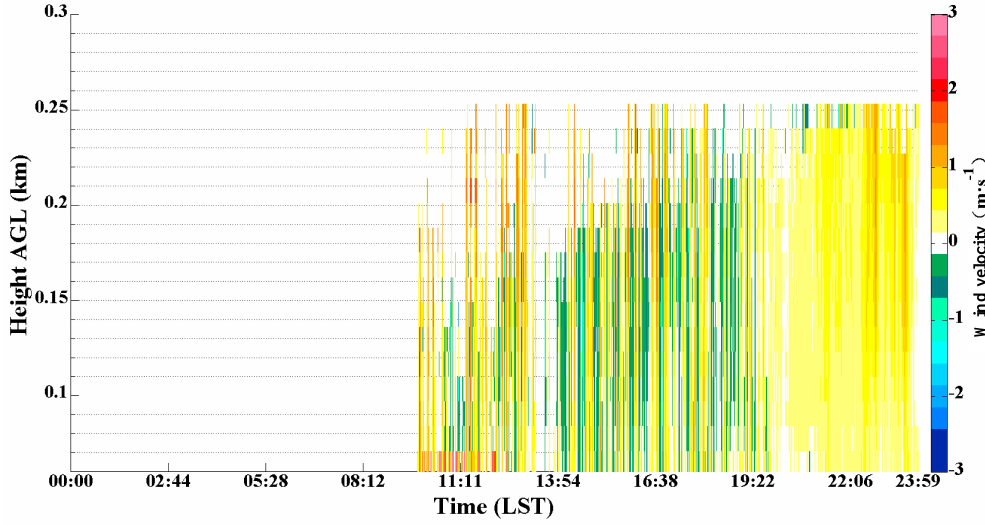
Figure 8. Time serials of vertical wind velocity from 00:00 to 23:59LST on 15 July